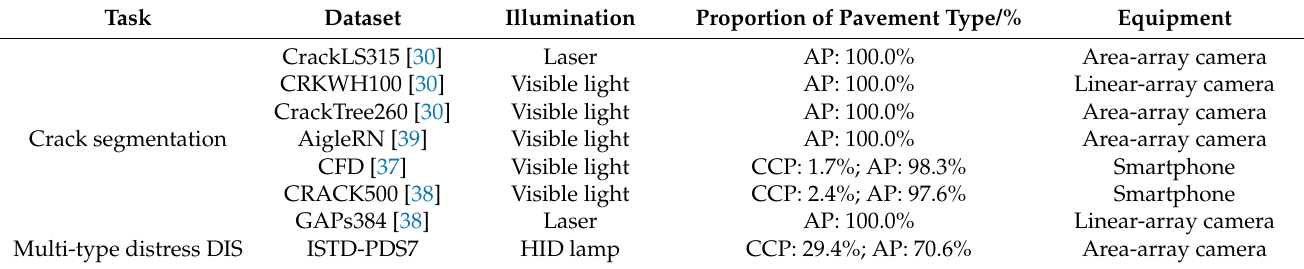
Table 1. Comparison of the established publicly available datasets for pavement distress segmentation. AP and CCP are the abbreviations for asphalt pavement and cement concrete pavement,